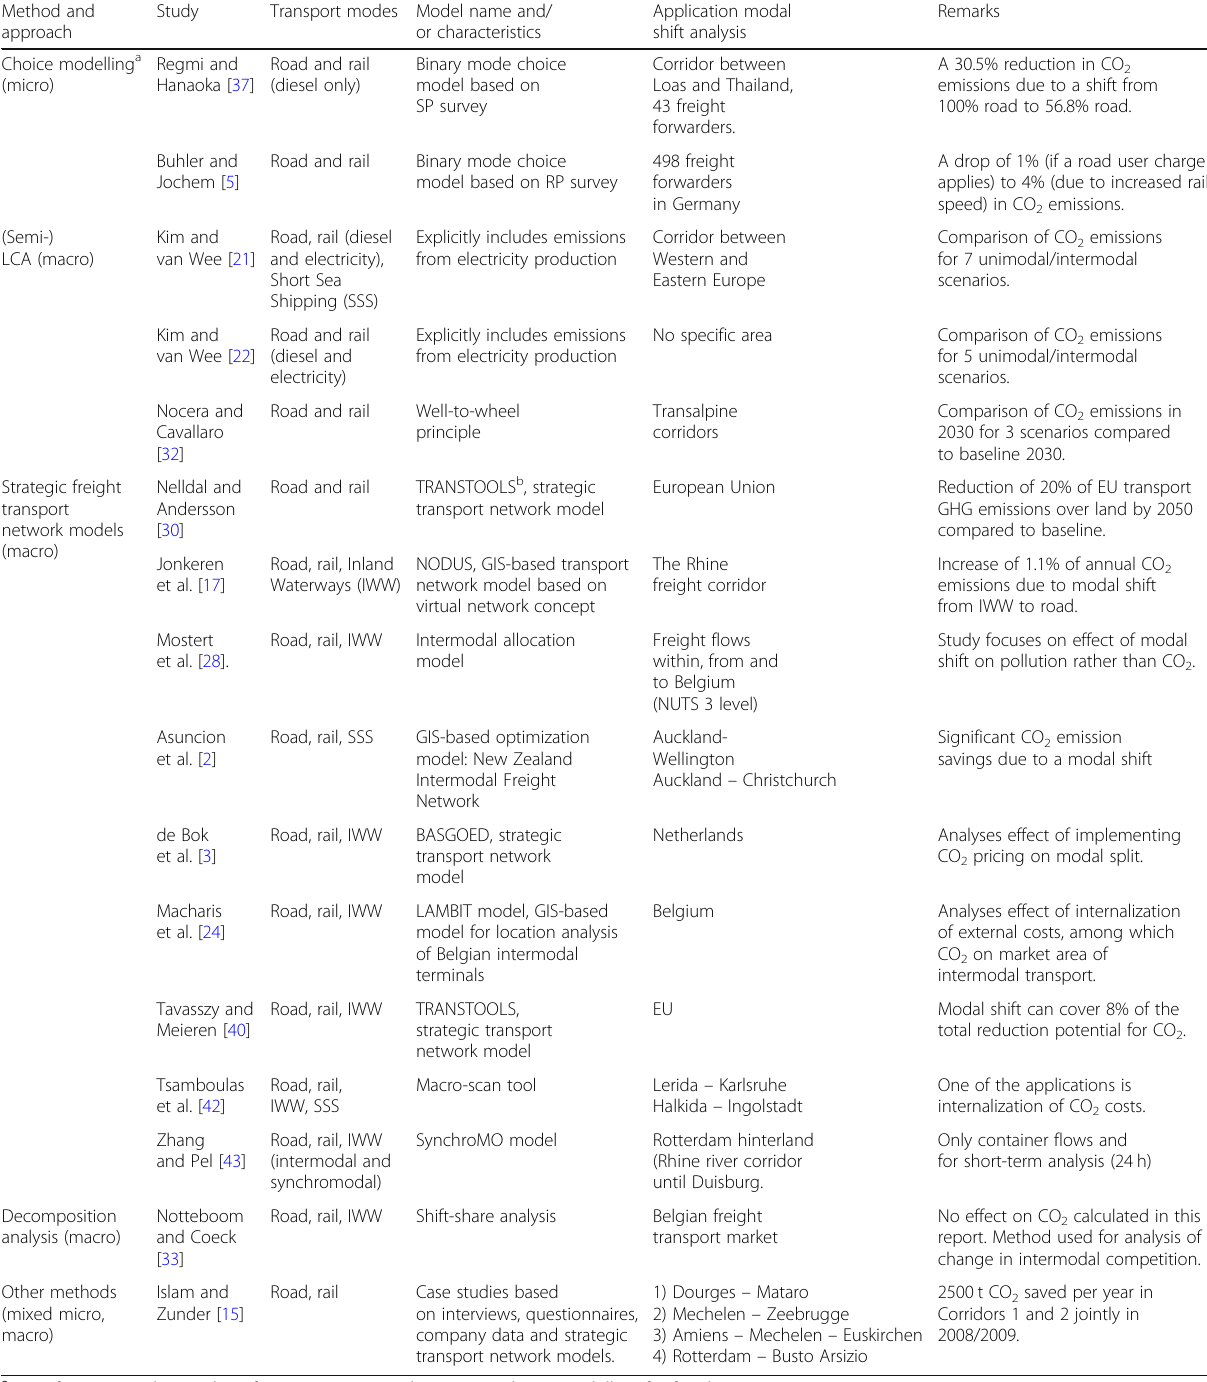
Table 2 Methods for analyzing modal shift in freight transport and its CO 2